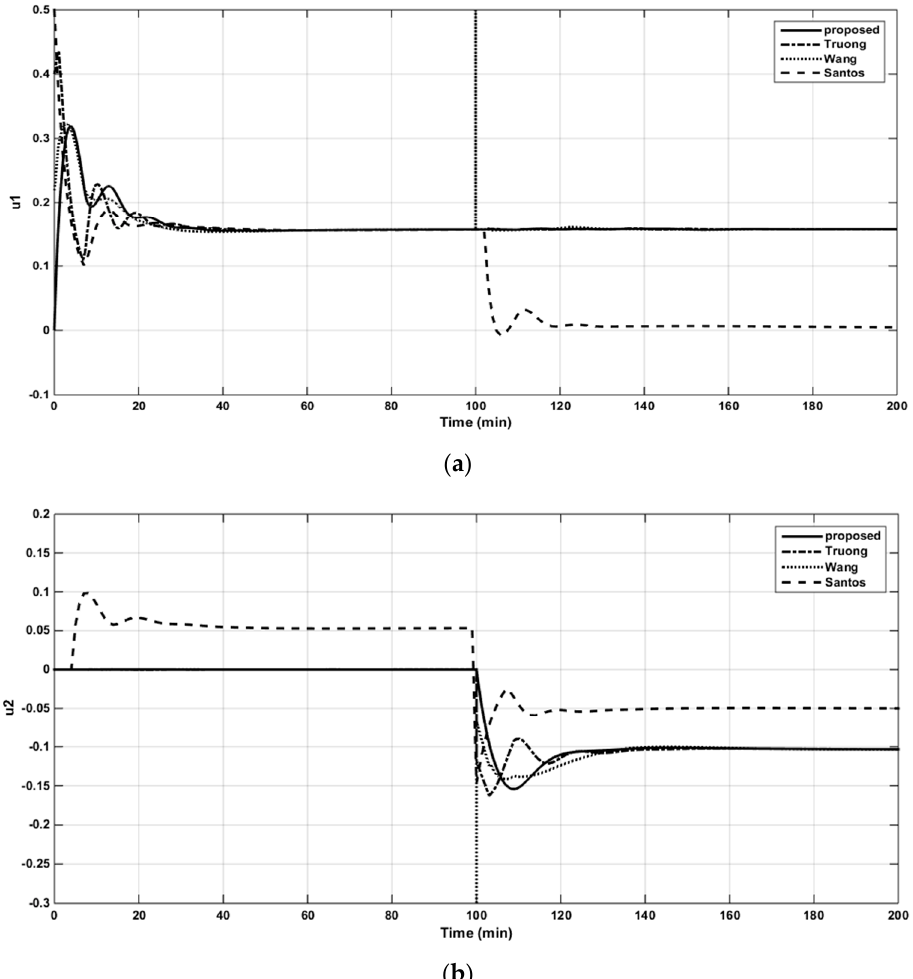
Figure 11. The control signal in loop 1 of the WB column ( a ). The control signal in loop 2 of the WB column ( b ).